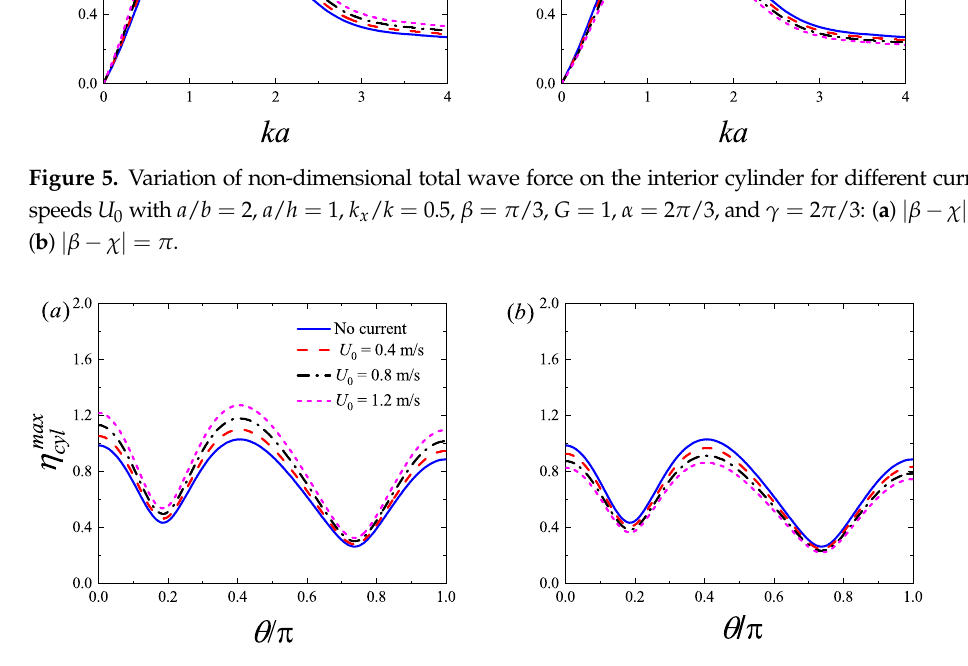
Figure 6. Variation of non-dimensional wave run-up on the interior cylinder for different currrent velocity U 0 with ka = 4, a / b = 2, a / h = 1, k x / k = 0.5, G = 1, β = π /3, α = 2 π /3, and γ = 2 π /3: ( a ) | β − χ | = 0; ( b ) | β − χ | = π